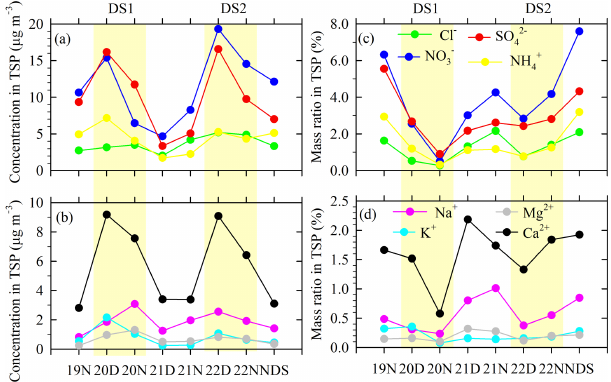
Figure 6. Variations in the concentrations of water-soluble ions and their mass ratios in TSP during 19–22 March and NDS in 2010.